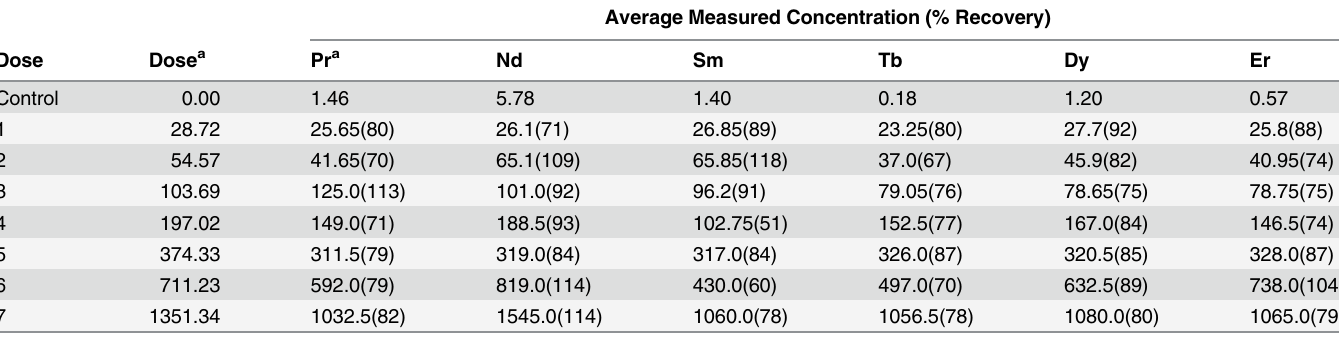
Table 3. Average measured concentrations of rare earth elements (mg REE/kg dry soil) in control and dosed soils as compared to the expected nominal doses.